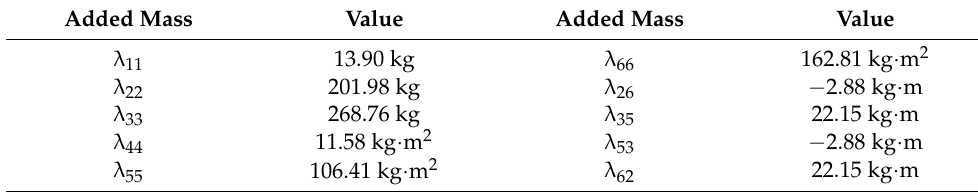
Table 2. The added mass of Petrel-X PLUS .